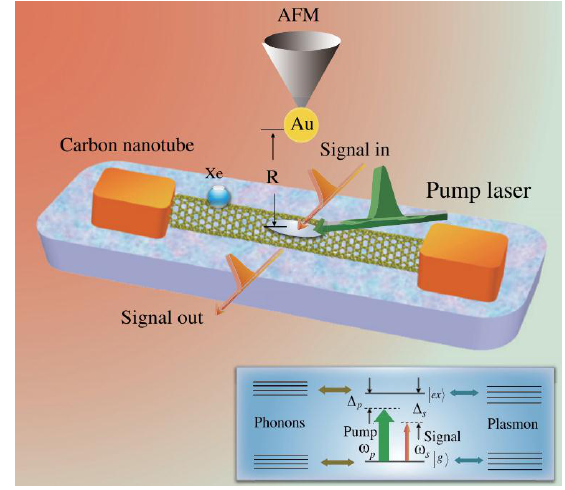
Figure 4. Schematic of a mass sensor based on a doubly clamped carbon nanotube. Adapted with permission from [29], Copyright IOP, 2012.